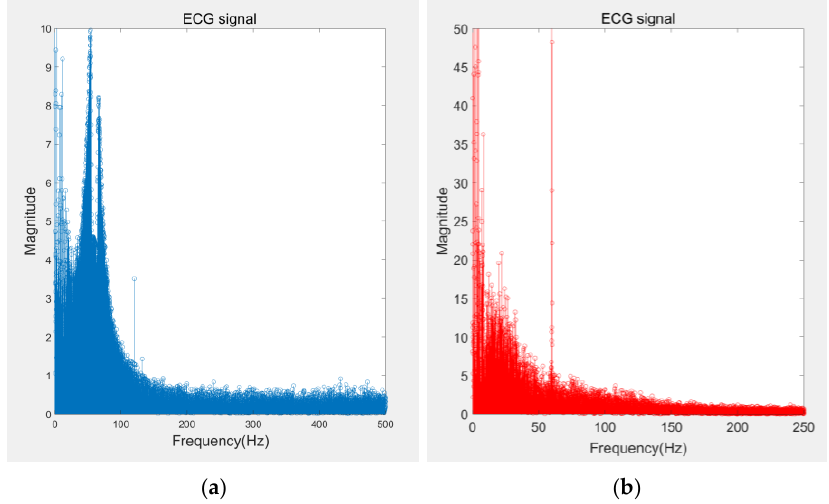
Figure 14. Fourier transform was applied to two ECG signals with different frequency characteris- tics. After applying digital filters to eliminate noise, Fourier transforms confirmed that the designed filter removed the signal in the appropriate frequency